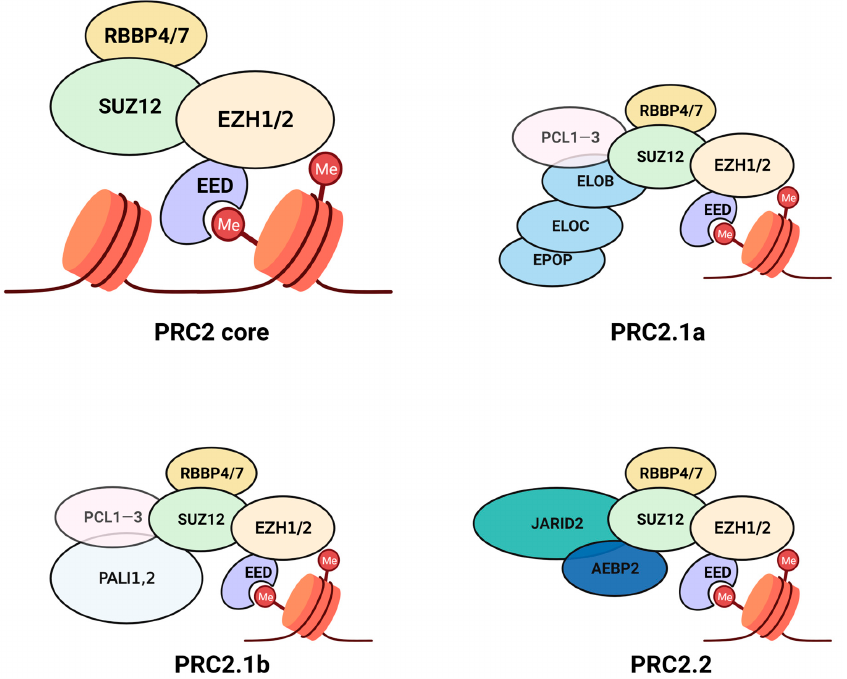
Figure 1. The Polycomb repressive complexes targeting histone 3 consist of a catalytic core and multiple accessory proteins that vary by function and cellular context. Complex subunits are depicted in proportion to their size (i.e., number of amino acid residues). Polycomb repressive complex 2 (PRC2) consists of a tetrameric core, where methyltransferase activity of EZH1/2 is stimulated by EED binding to methylated H3K27, while SUZ12 and RBBP4 stabilise the overall complex. The non-canonical or ncPRC2 complexes are formed by the recruitment of accessory proteins by SUZ12. EPOP, ELOC, ELOB, and PCL1-3 are recruited in ncPRC2.1a and PALI1—2 and PCL1—3 in ncPRC2.1b complexes, while JARID2 and AEBP2 are accessory components of the ncPRC2.2 complex. This figure was created with BioRender.com.